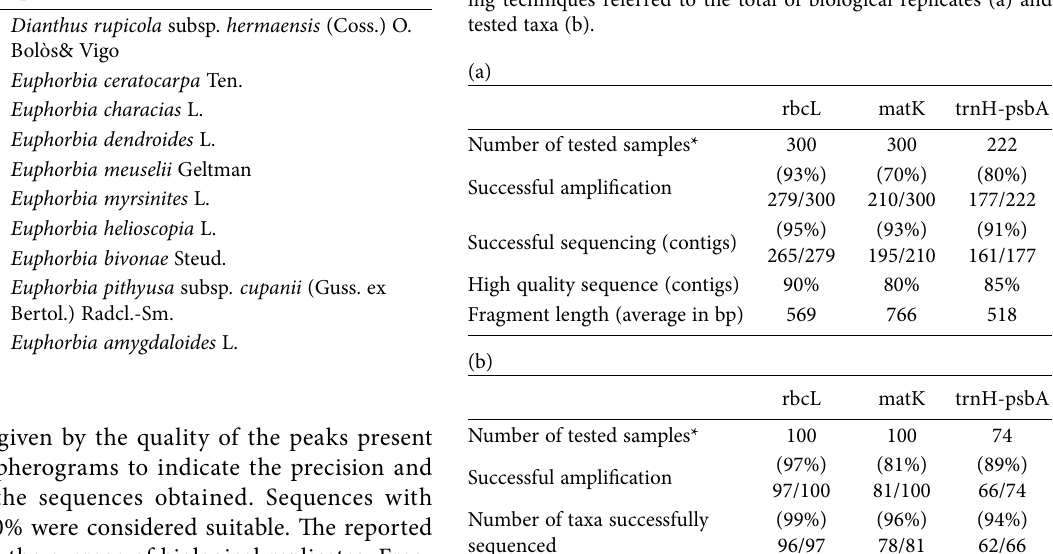
Table 2. Technical performancesof markers used in DNA barcod- ing techniques referred to the total of biological replicates (a) and tested taxa